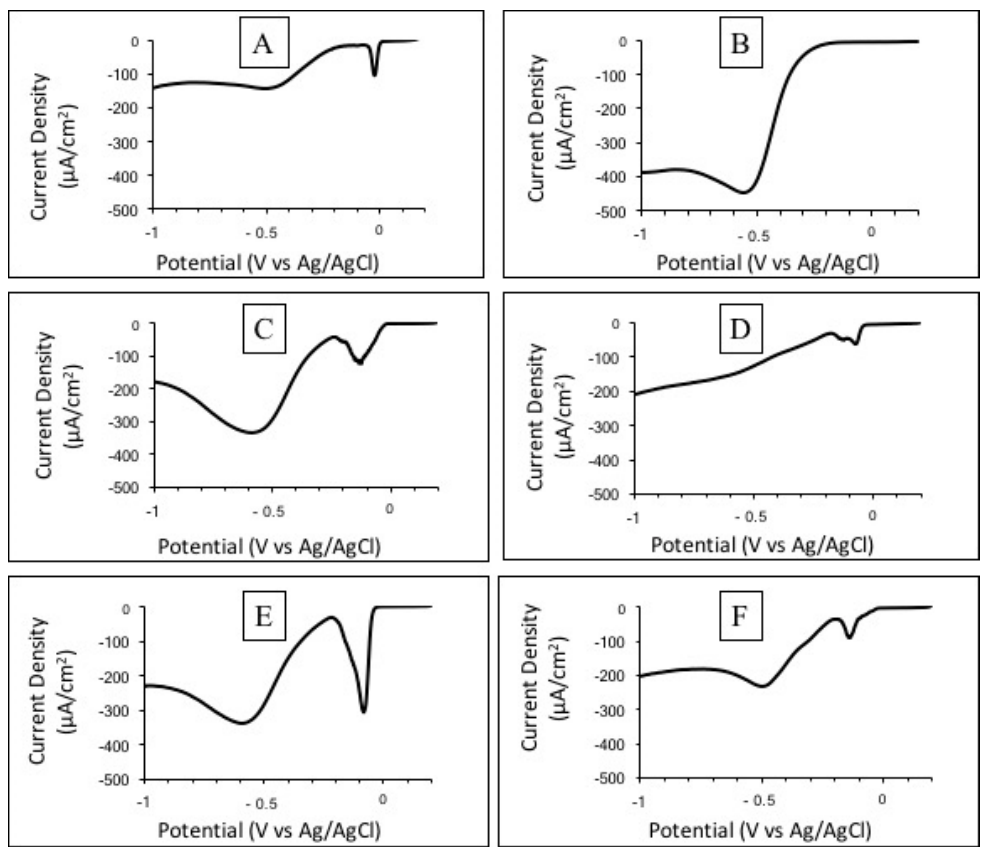
Figure 7. LSV tests conducted on isolates obtained from biocathodes. Representative volumetric profiles of isolates: ( A ) Herbaspirillum . ( B ) Ancylobacter . ( C ) Rhodococcus . ( D ) Methylobacterium . ( E ) Sphingomonas . ( F ) Pseudomonas .